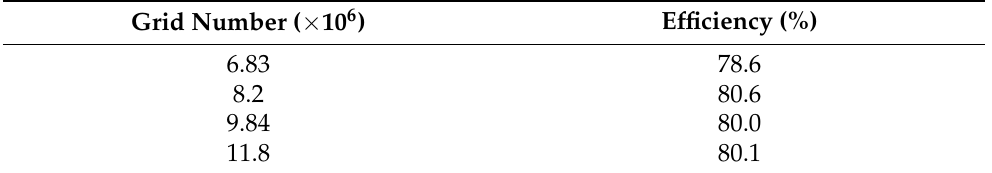
Table 1. Grid independence